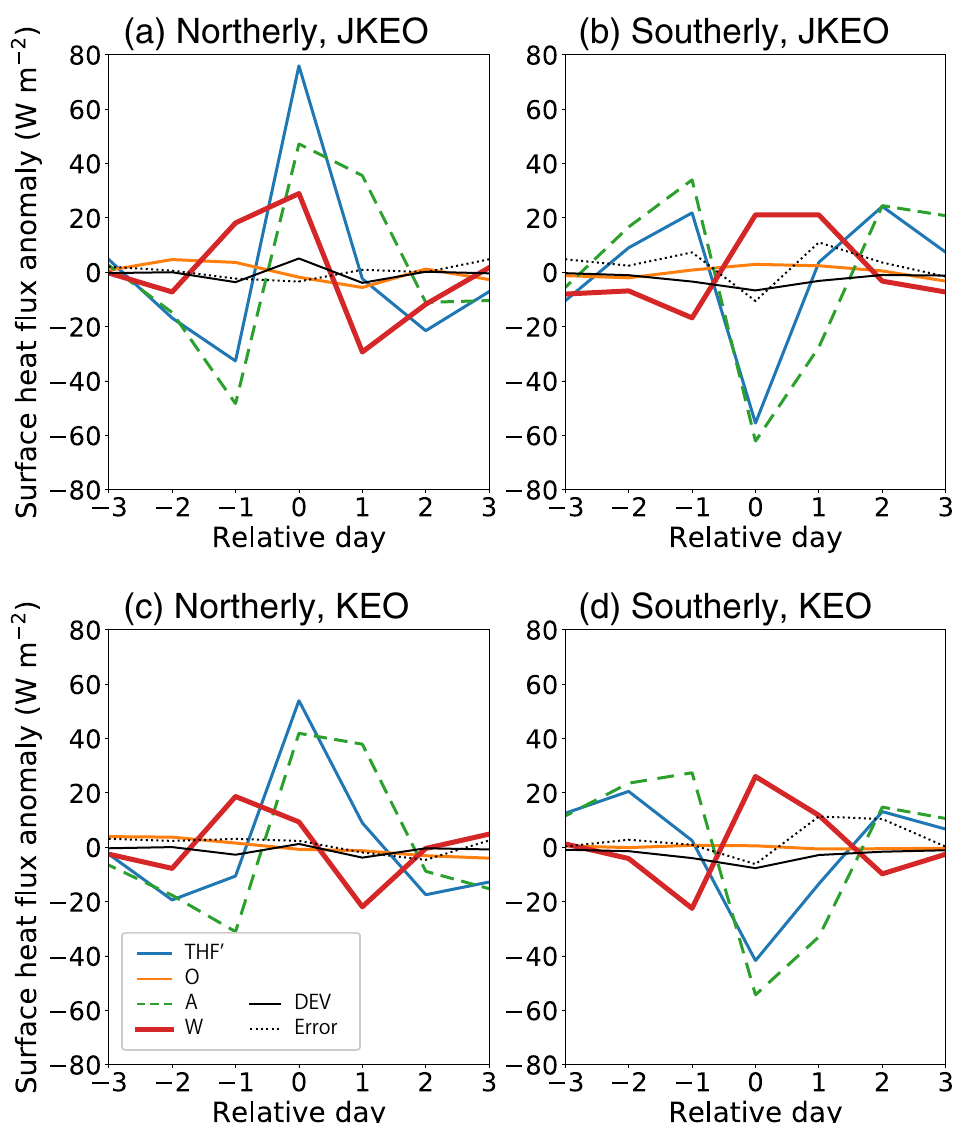
Figure 6. Surface turbulent heat flux variation and its contributing factors. ( a ) and ( b ) are northerly and southerly composites at JKEO, respectively. ( c ) and ( d ) are northerly and southerly composites at KEO, respectively. THF’ indicates an anomaly from the temporal mean during the 7-day composite. O, A, W, DEV, and error are contributions from changes in the ocean, atmosphere, winds, their perturbations, and error. See “Data and methods” for